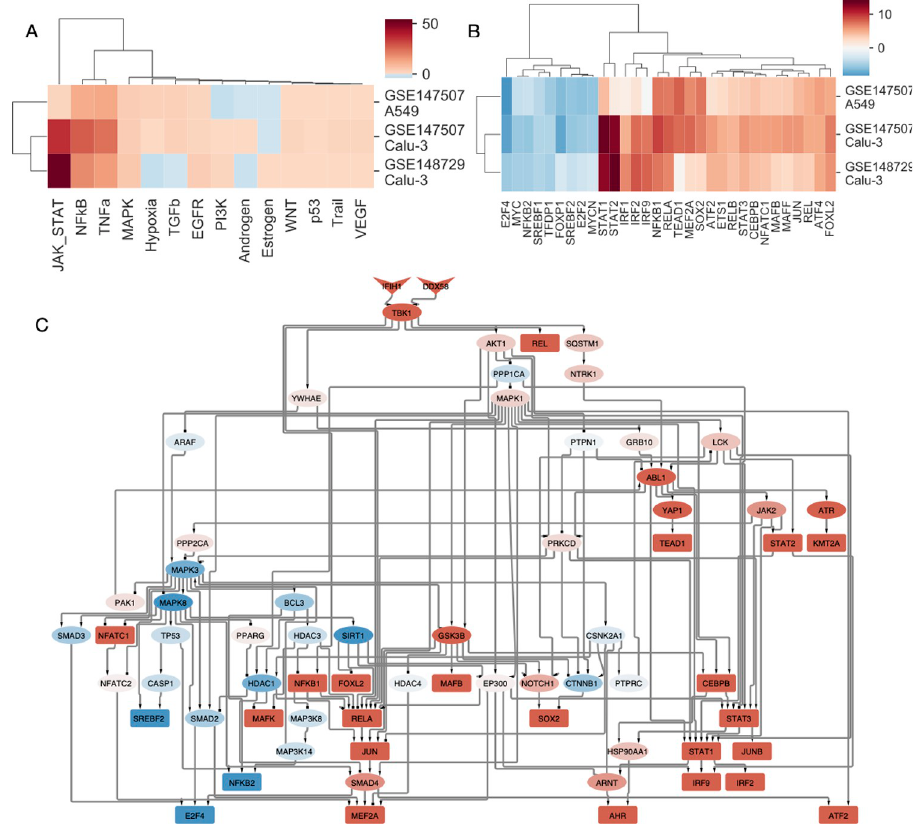
Fig 1. Functional genomic analysis of SARS-CoV-2 infected cell lines. (A) Inferred pathway and (B) TF activities of SARS-CoV-2 infected samples from lung epithelial cell lines (Calu-3 and A549). Activities were calculated from differential expression signatures (infected—control) using PROGENy and DoRothEA tools for pathway and TF activities, respectively. Only TFs with high absolute level of activity changes (absolute normalized enrichment score > 4) are shown. (C) Causal signalling network in SARS-CoV-2 infected Calu-3 cells (GSE147507) identified by CARNIVAL. RIG-I like receptors (DDX58 and IFIH1) as perturbation targets and DoRothEA inferred TF activities were used as the input of the CARNIVAL pipeline. Color code represents inferred activity of protein nodes (blue: inhibited, red: activated).